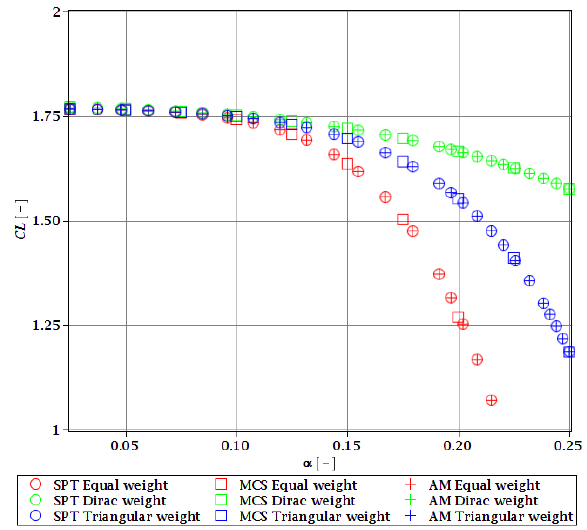
Figure 8. Expectations of the critical load for different types of weights.